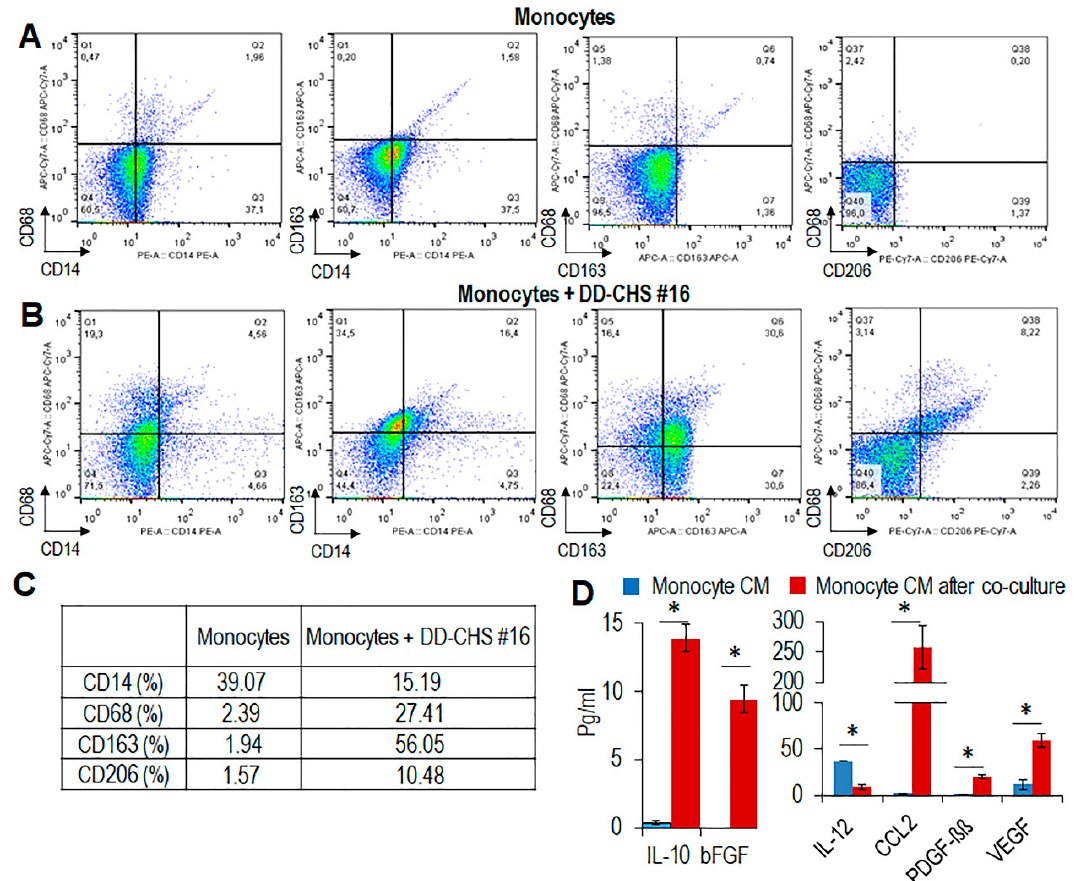
Figure 6. Immunophenotyping of primary human monocytes co-cultured with CHS cells. Human monocytes from healthy donors were co-cultured with primary CHS cells. ( A , B ). After 72 h, monocytes were recovered and their phenotype analyzed by flow cytometry. ( C ). Percent variation of CD14 + , CD68 + CD163 + , and CD206 + cells upon co-culture with CHS cells, compared to control (monocytes alone). ( D ). After co-culture, CHS were removed, and monocyte conditioned media were prepared and analyzed by a Bio-Plex immunoassay. The concentration of significant soluble factors (expressed in pg / mL) are reported as mean ± SD from two experiments performed in quadruplicate. Statistical significance with * p < 0.001.